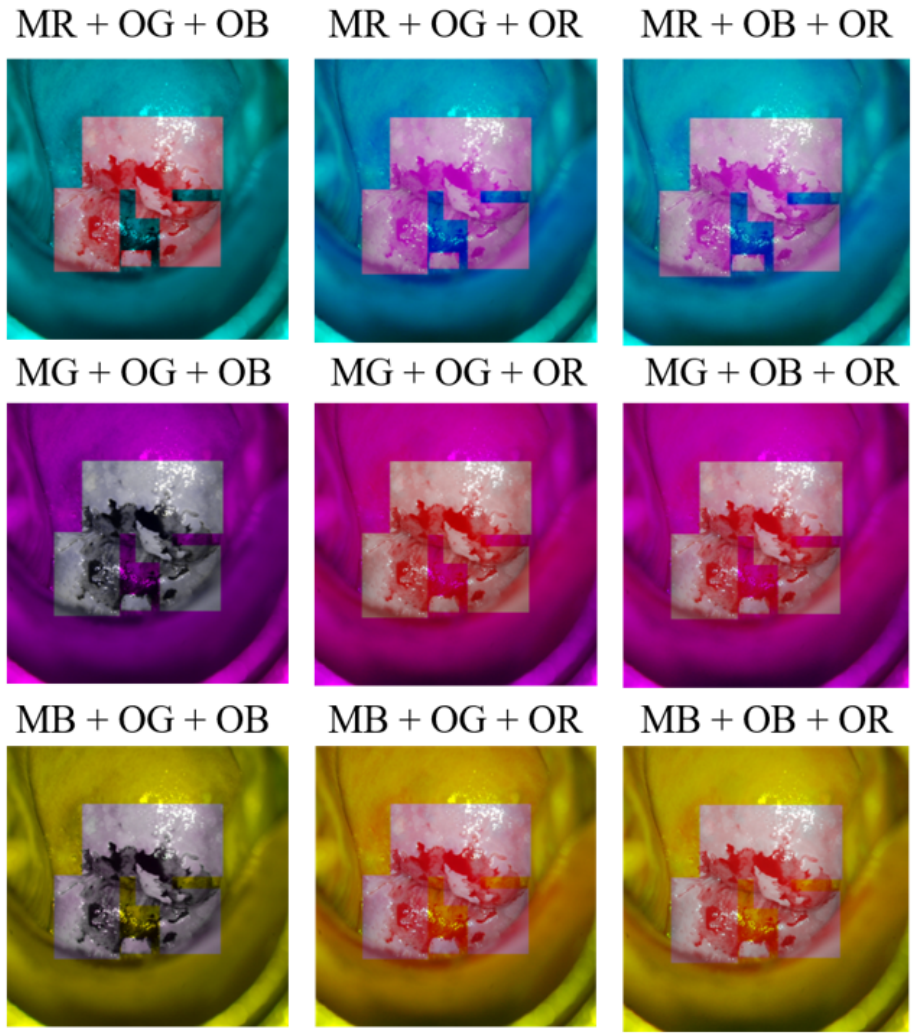
Figure 2. Nine cases of cervical images made through RGB channel superposition. Each RGB channel superposition image consisted of 438 A1 and 477 P1B images iden-